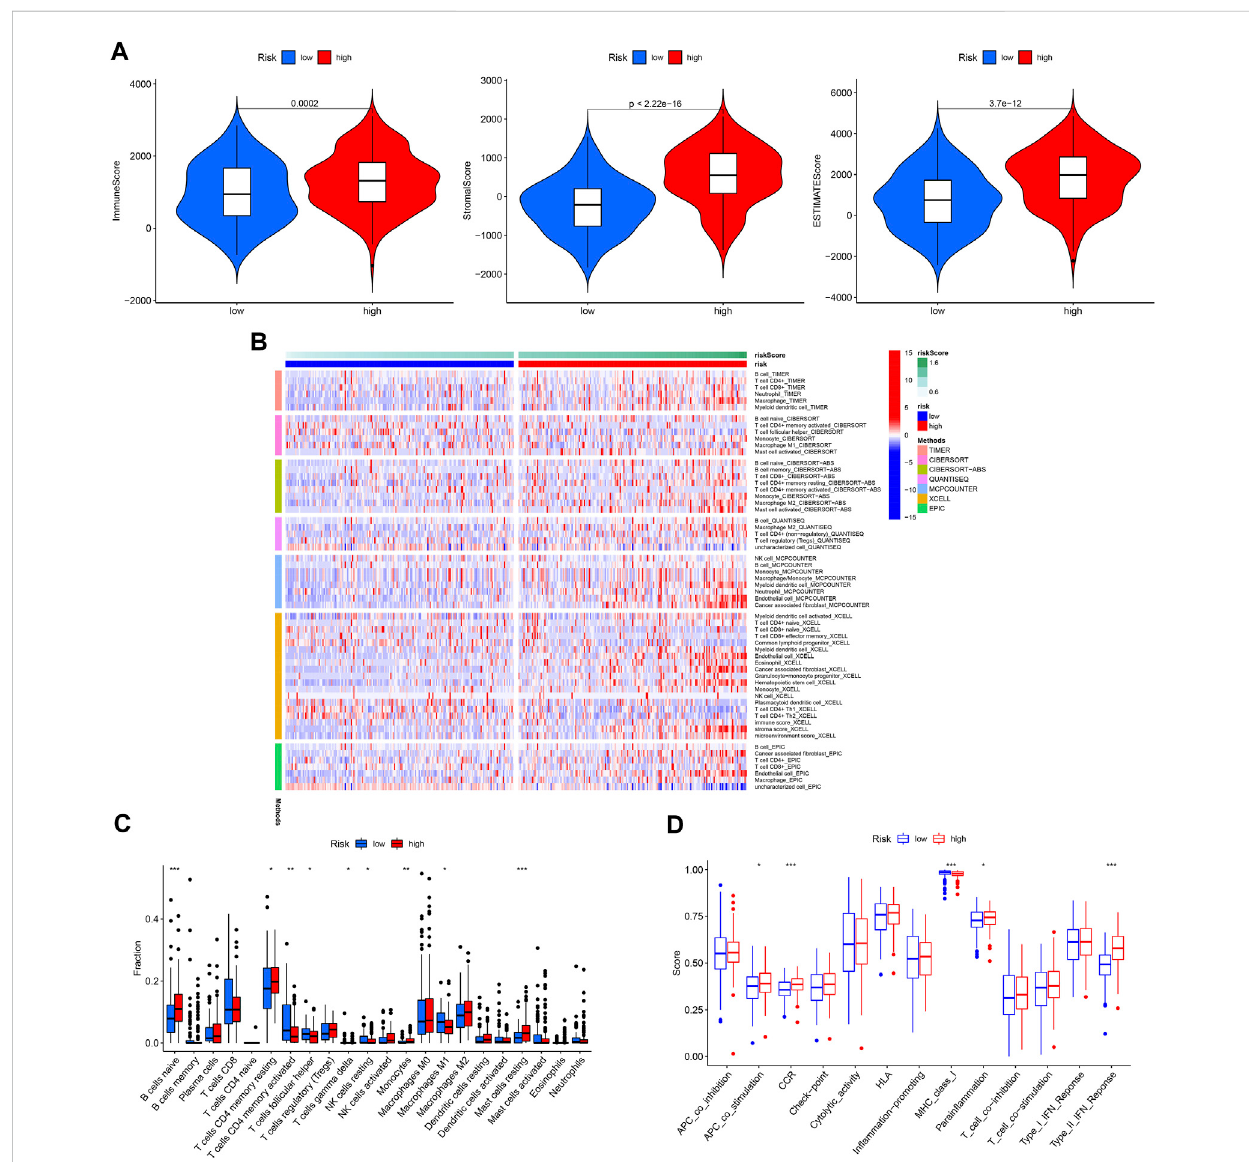
FIGURE 10 Immune cell in fi ltration pattern indifferent risk GC. (A) Tumor purity analysis. (B) Immune cell in fi ltration ofdifferent risk GC. (C) ssGSEA analysis. (D) Immune function analysis of different risk